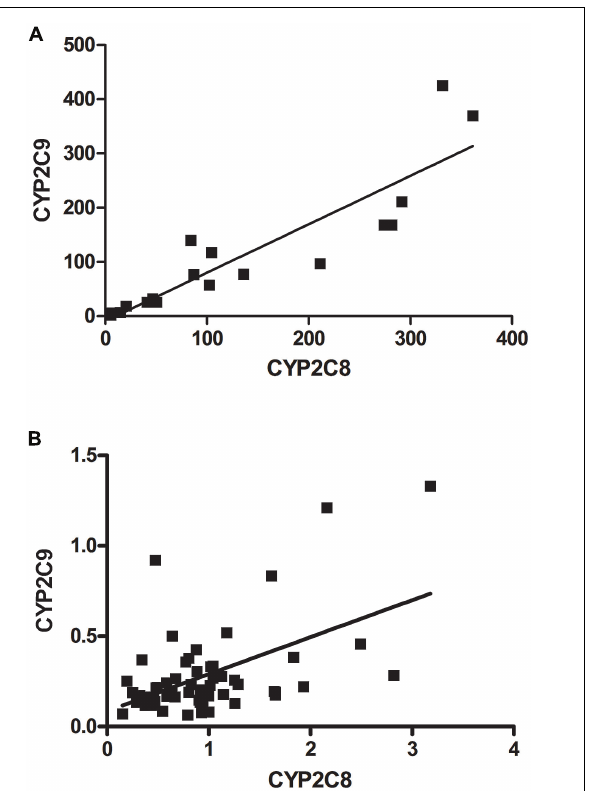
FIGURE 3 | Relative mRNA expression of CYP2C8 correlated with the relative mRNA expression of CYP2C9 in (A) adult liver and (B) fetal liver. The correlation study shows a significant association between the mRNA expression of CYP2C9 and CYP2C8 in (A) adult liver ( r = 0.8962, p < 0.0001) and in (B) fetal liver ( r = 0.3844, p =